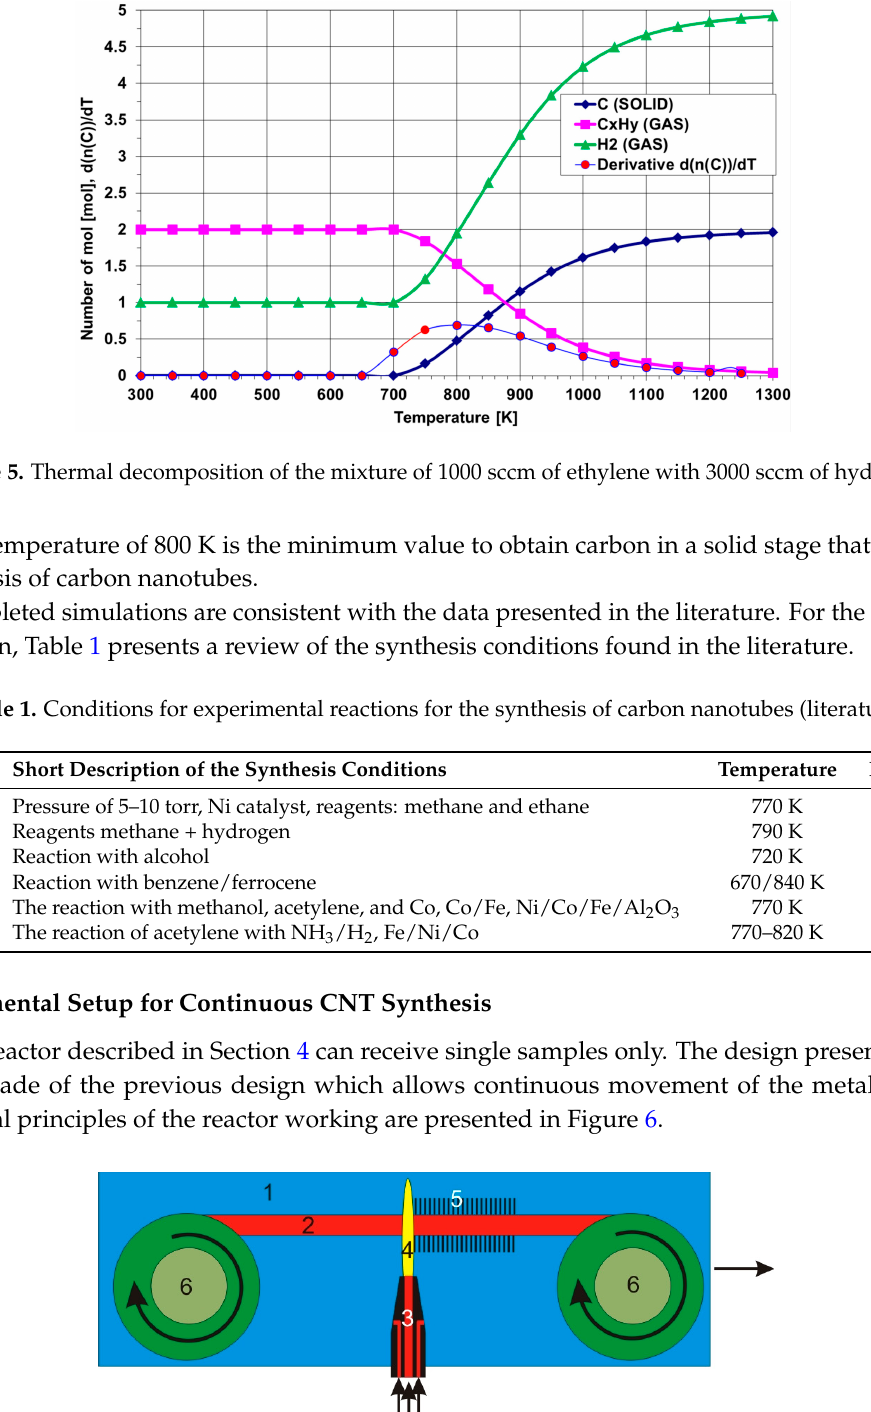
Figure 6. Schematic diagram of the continuous microwave plasma system for CNT synthesis where: